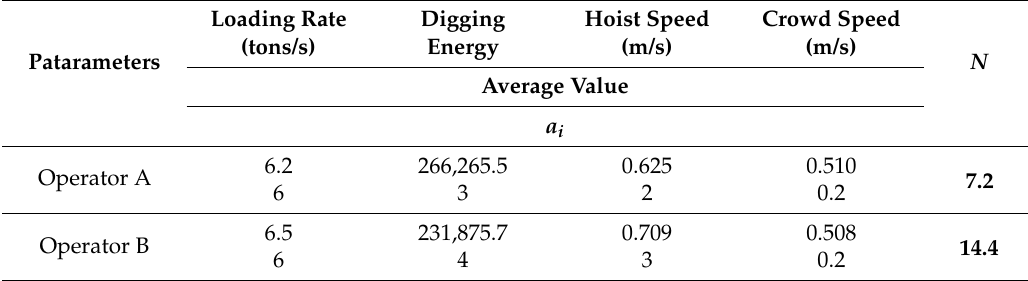
Table 5. N values for Operators A and